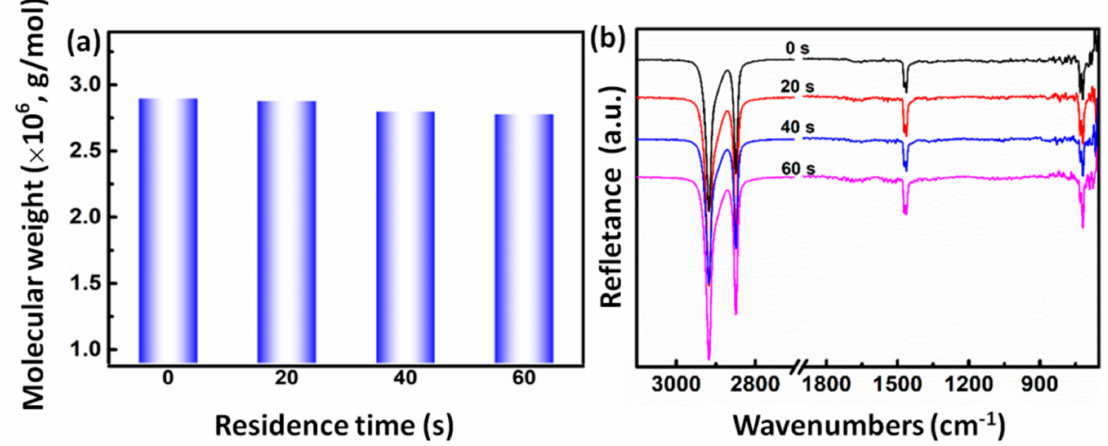
Figure 5. Molecular weight ( a ) and Infrared spectra ( b ) of the UHMWPE samples under a consecutive elongational flow for 0 to 60 s residence